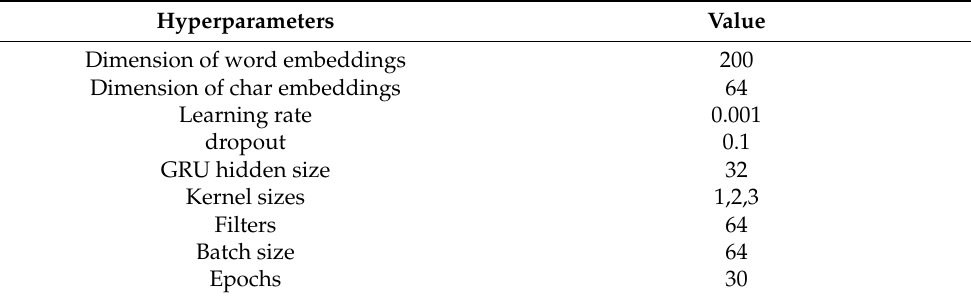
Table 2. Hyperparameters